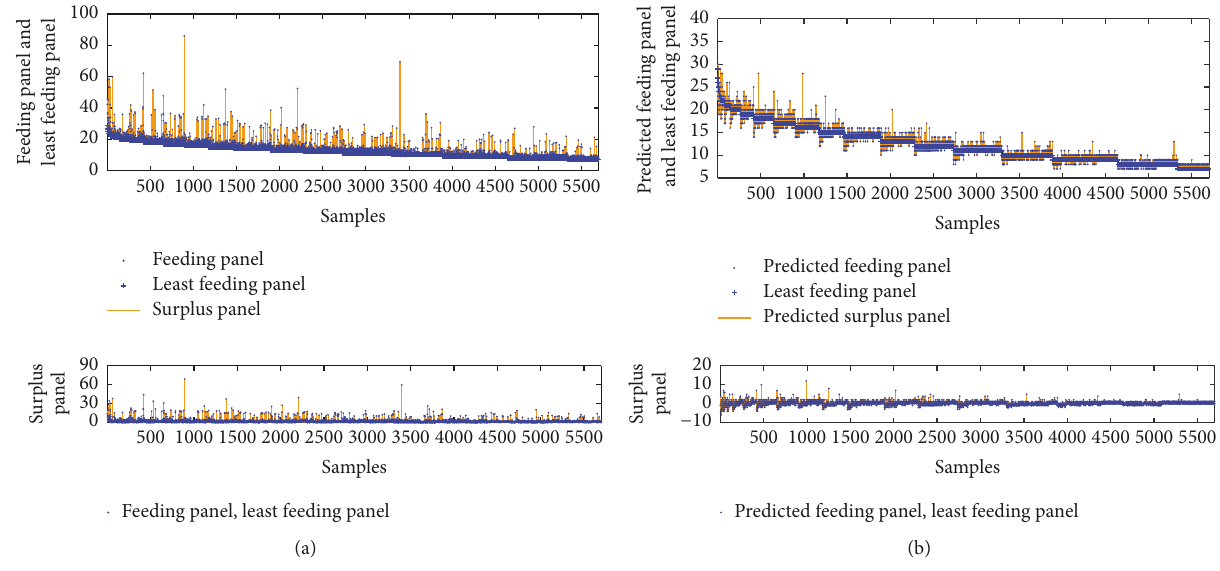
Figure 11: (a) Deviation of samples between manual feeding panel and least feeding panel. (b) Deviation between predicted feeding panel and least feeding